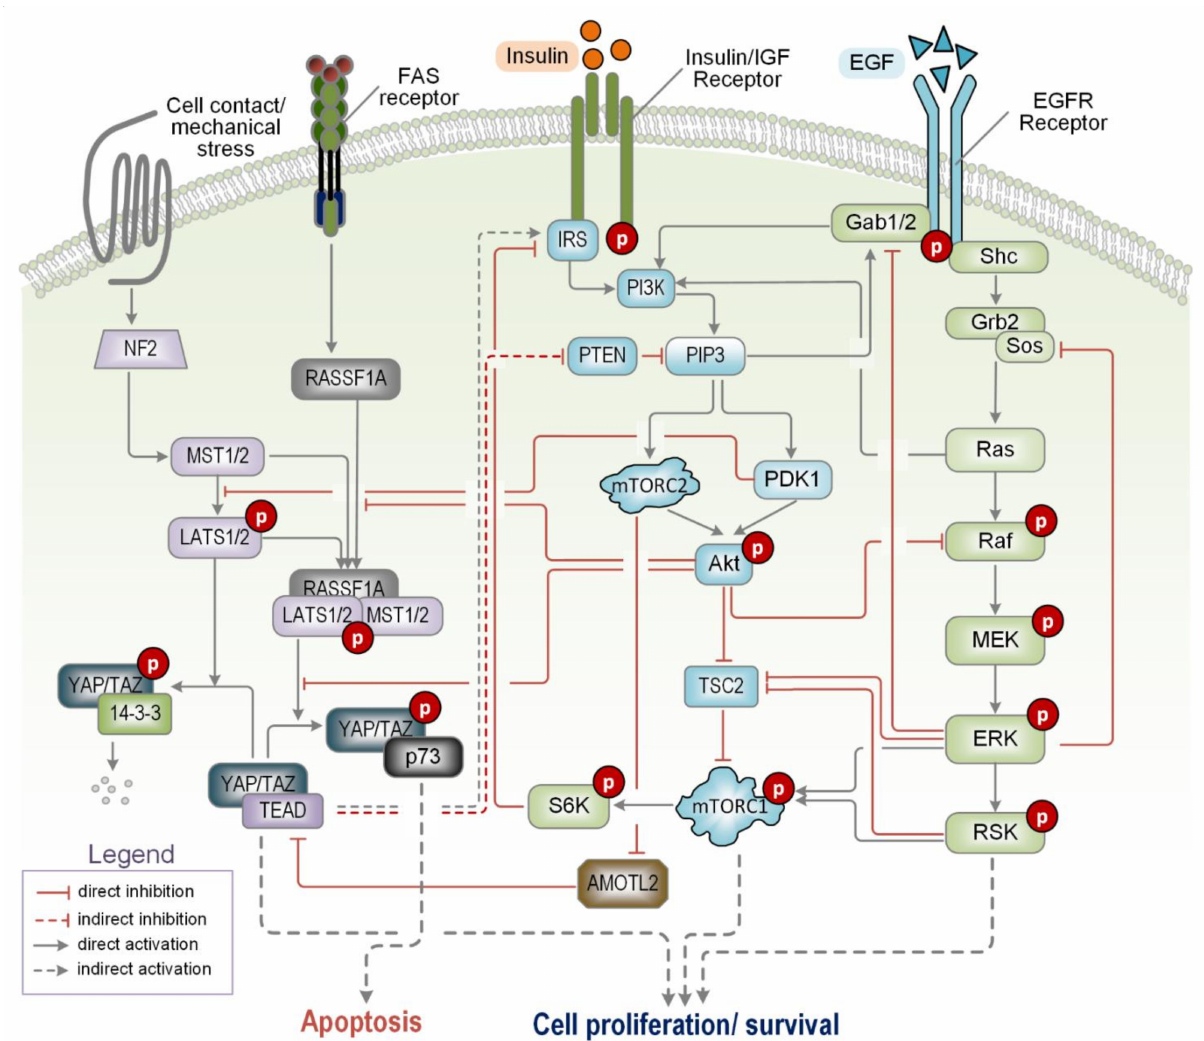
Figure 3. A schematic diagram displaying representative crosstalk interactions between the PI3K/mTOR, Hippo and ERK/MEK signalling pathways. For a more detailed description see the main text. YAP suppresses PTEN translation via the microRNA miR-29. mTORC2 phosphorylates and inhibits AMOTL2, a YAP inhibitor. The phosphorylation of AMOTL2 releases YAP inhibition and promotes YAP-mediated transcription. Akt phosphorylates MST2 at Thr-117 and Thr-384 which blocks MST2 from binding to RASSF1A and inhibits MST2 kinase activity toward LATS. PDK1 promotes the dissociation of MST1/2 from SAV1/WW45 and reduces LATS1 kinase activity. Akt phosphorylates YAP at Ser-127 which retains YAP in the cytoplasm. Akt phosphorylates and inhibits RAF. ERK/RSK phosphorylate and inhibit the TSC complexes, thereby promoting mTORC1 activation. ERK/RSK also directly upregulate mTORC1 through RAPTOR phosphorylation. Tyrosine phosphorylated of Gab1/2 by growth factor stimulation serves as a docking protein for PI3K, which enhances its activation. ERK phosphorylates Gab1/2, triggering its dissociation from the plasma membrane and downregulation of PI3K signalling. RAS interacts with PI3K p110 α and promotes PI3K